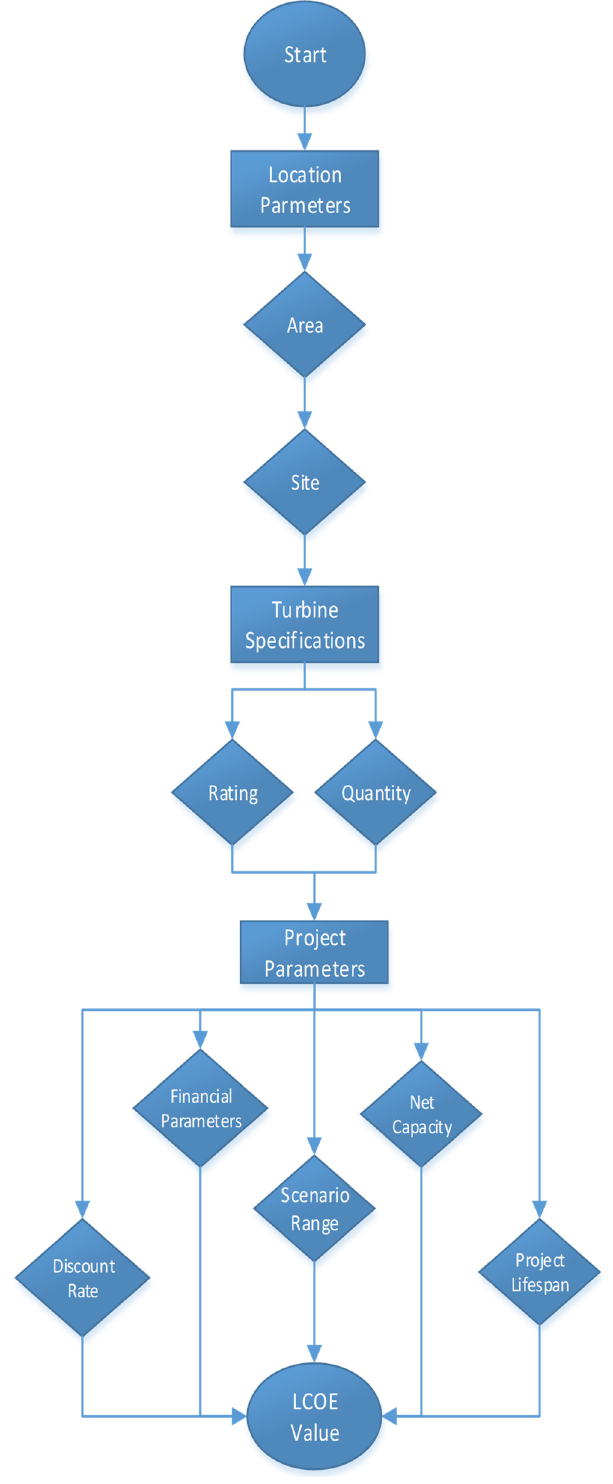
Figure 3. Flowchart description of calculator design.